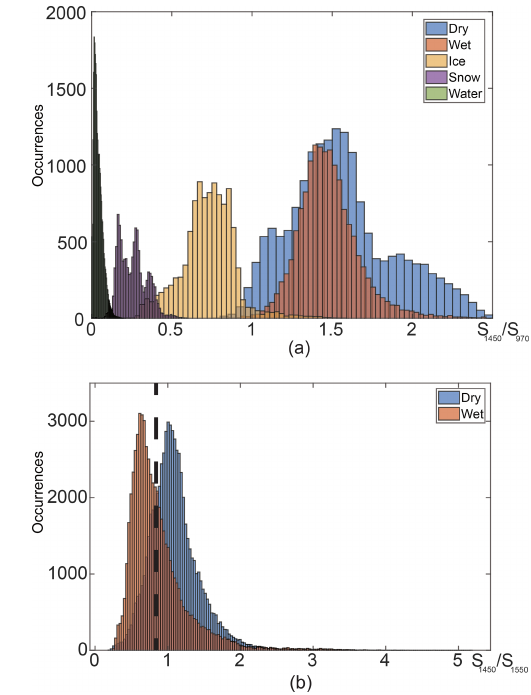
Figure 13. (a) Histogram of S 1450 /S 970 . (b) Histogram of S 1450 /S 1550 . Dashed line represents the threshold at the intersec- tion point of the wet and dry distributions.